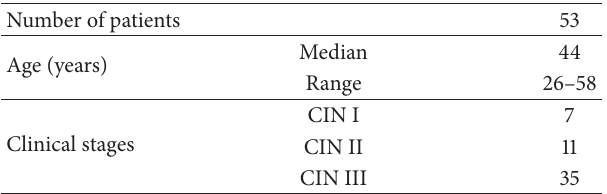
Table 2: Clinical characteristics of patients with cervical intraep- ithelial neoplasia